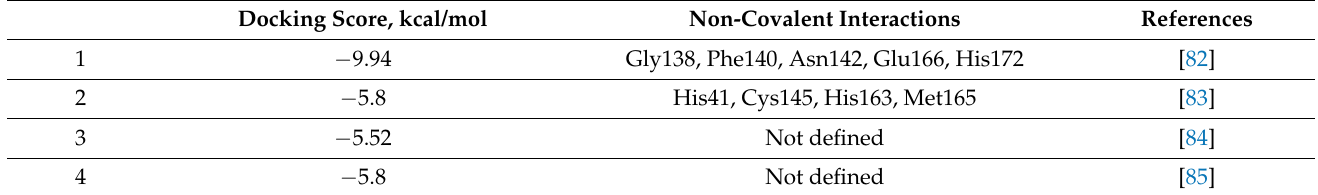
Table 4. Results for Triazavirin docking to the main 3CL-protease of SARS-CoV-2. Docking Score, kcal/mol Non-Covalent